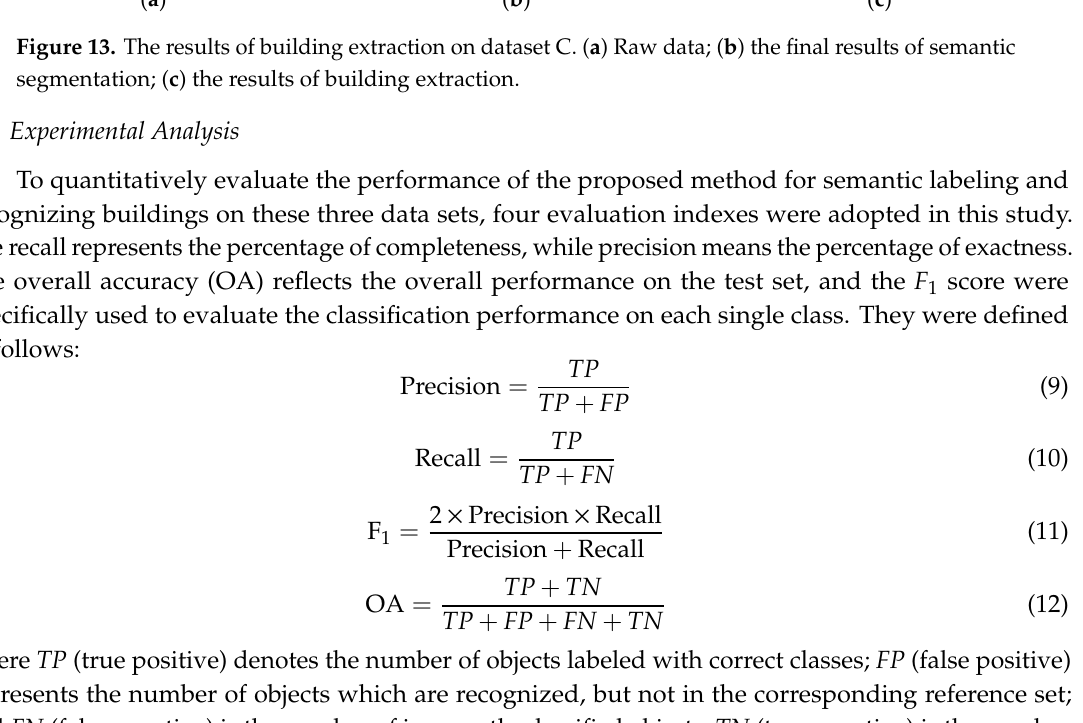
Table 2. Quantitative spatially smoothed results based on K-nearest neighbor. (Precision (P), Recall (R), 𝐹 (cid:2869) score (F1)).